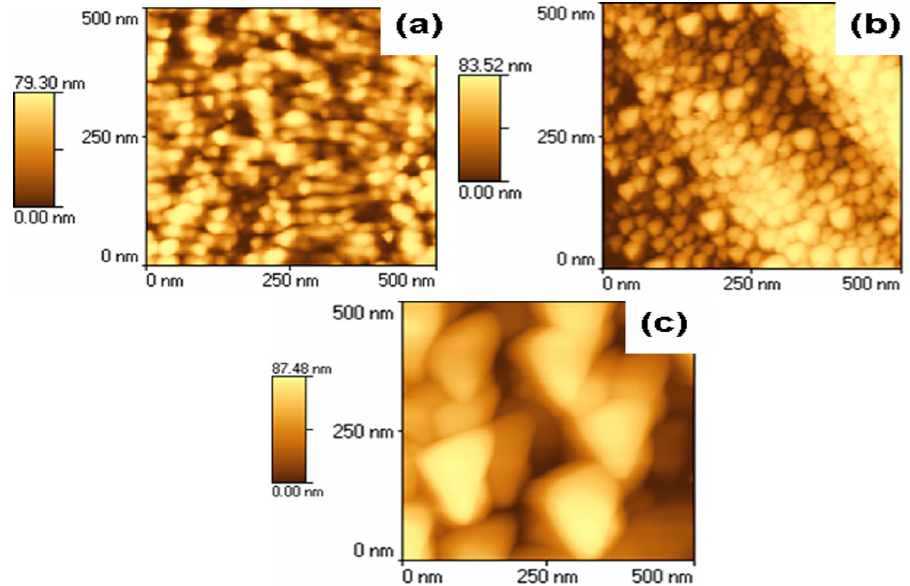
Figure 1. Atomic force microscopy (AFM) images of gallium arsenide (GaAs) nanostructures for ( a ) one, ( b ) two, ( c ) three shots on a silicon substrate placed at a distance of 4.0 cm.